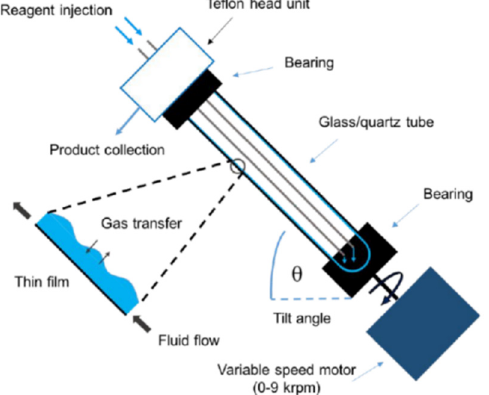
Figure 17. Scheme of the vortex fluidic device (VFD), a tubular rotating continuous flow reactor, lined with the catalyst-containing paper sheet [115].